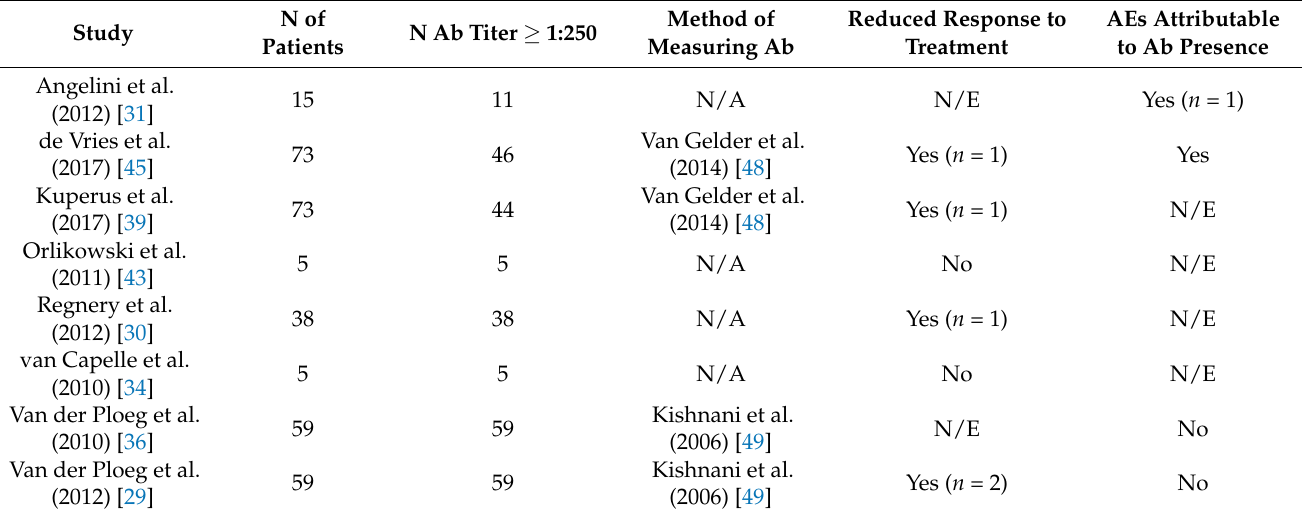
Table 5. Antibody titers for patients with late-onset Pompe disease receiving enzyme replacement therapy, reduction in response to treatment, and incidence of AEs. Method of Reduced Response to AEs Attributable N of N Ab Titer ≥ 1:250 Measuring Ab Treatment to Ab Patients